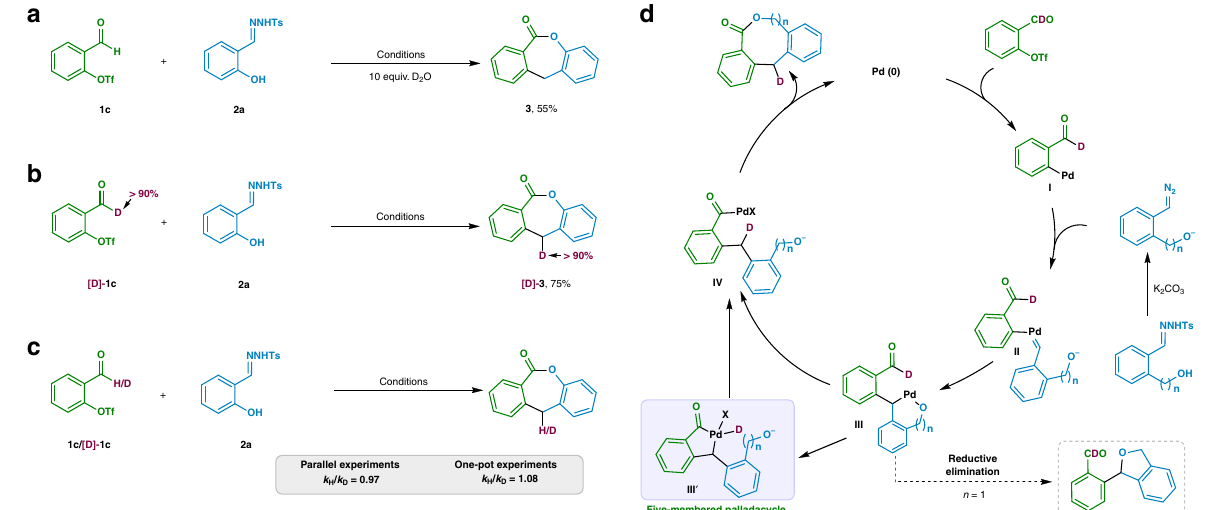
Fig. 2 Mechanistic experiments. a Reaction proceeded in presence of 10 equiv. of D 2 O. b Deuterium-labeling experiment as a probe for 1,4-palladium migration. c Kinetic isotopic effect experiment for C – H bond cleavage in aldehyde 1c . d Proposed catalytic cycle for palladium-catalyzed medium-sized lactone synthesis. X stands for possible counter